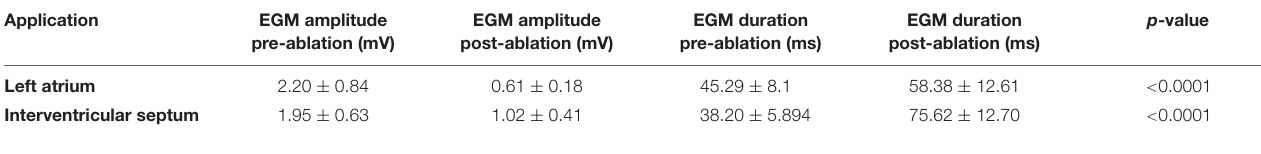
TABLE 1 | Electrophysiological parameters changes upon